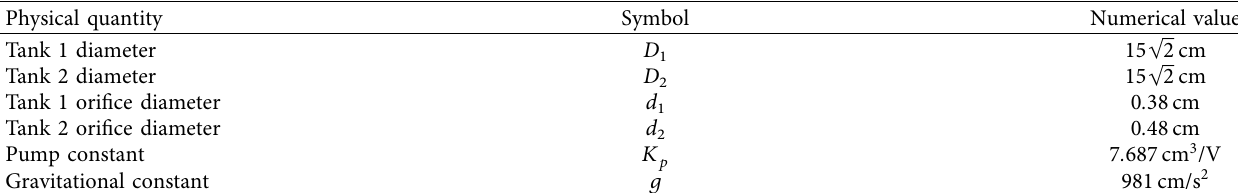
Table 1: Numerical values for physical parameters of the